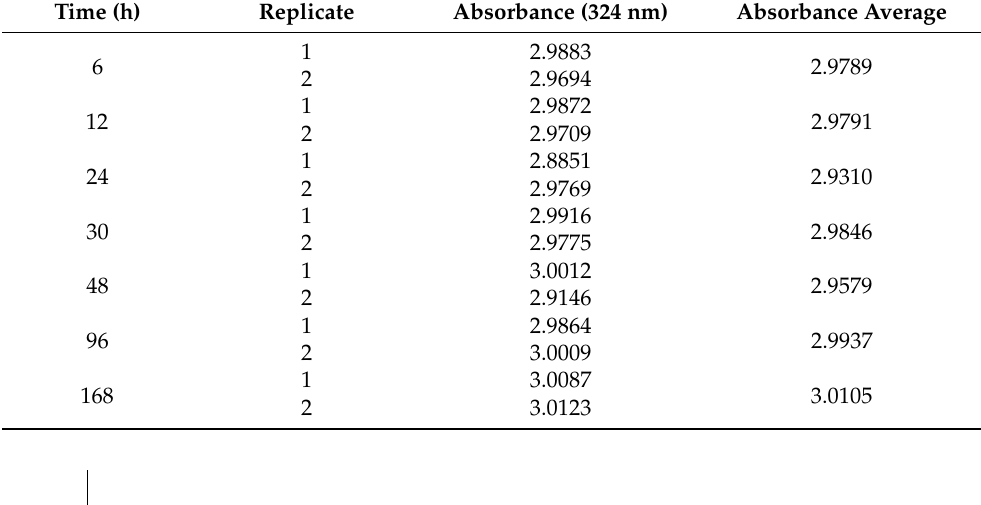
Table A1. Lifetime of the optical sensor based on the absorbance measurements for several days after the synthesis of the PIM.